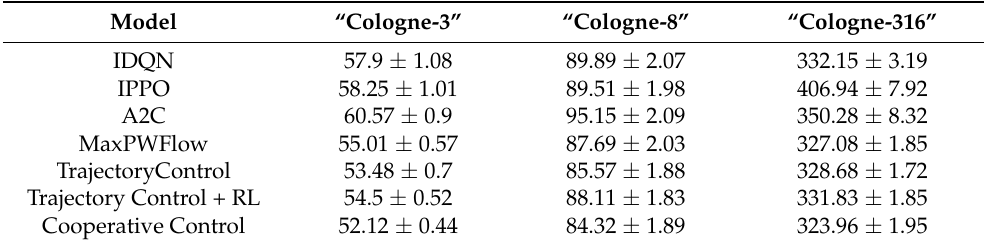
Table 3. Average travel time (sec) for different simulation scenarios.